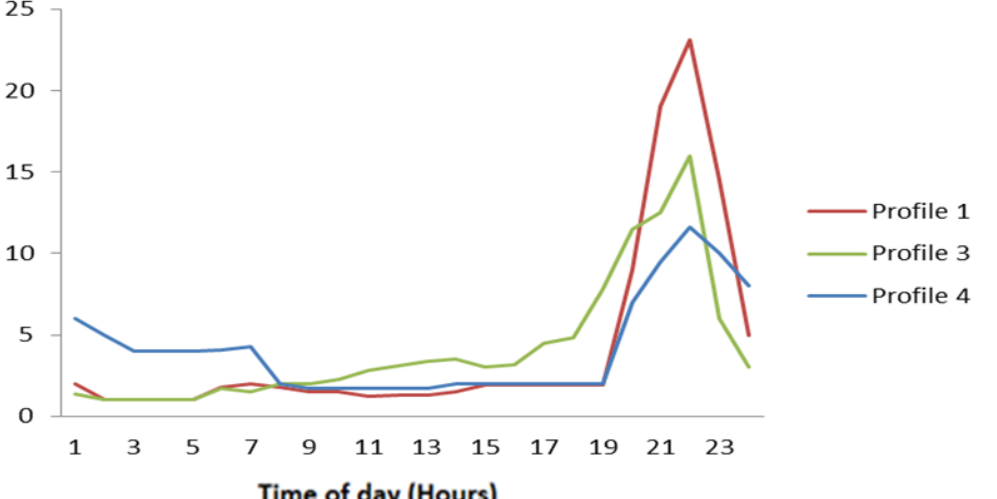
Figure 13. Household load profiles.